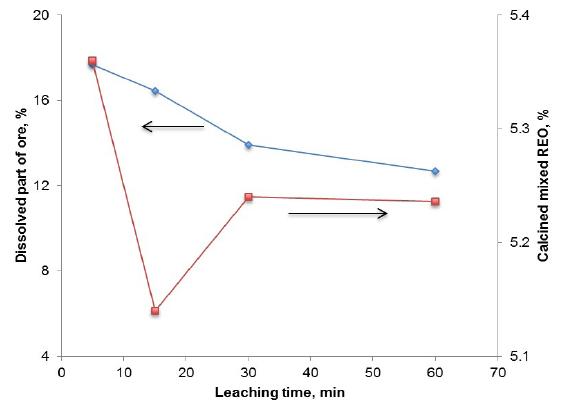
Fig. 1. Weight changes of ore and rare earth oxides content in the calcined precipitates with leaching time.